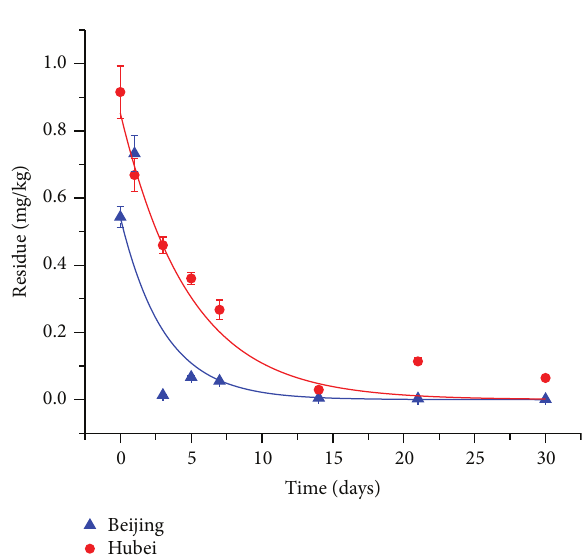
Figure 3: The dissipation curves of thifluzamide in paddy soil in Beijing and Hubei